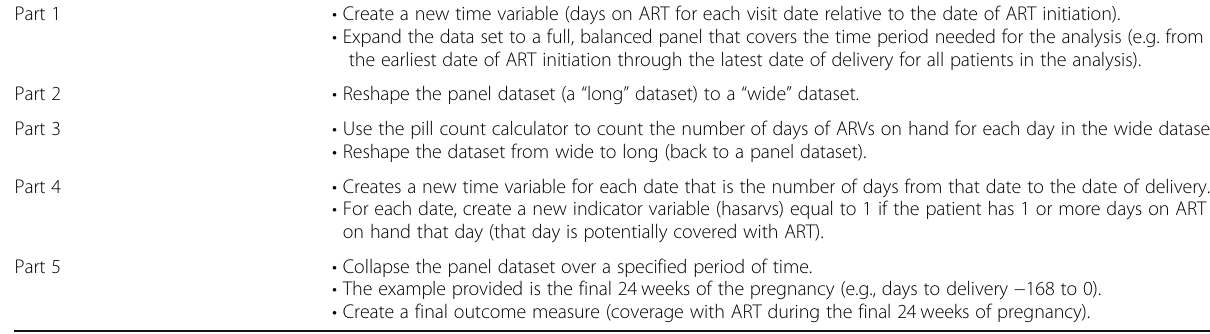
Table 3 A summary of the PMTCT-ACT